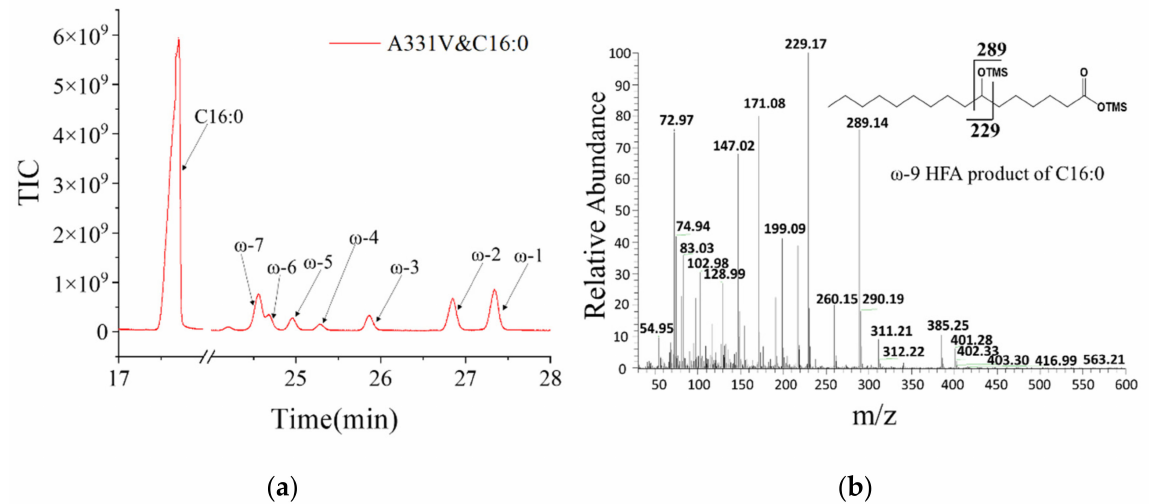
Figure 4. ( a ) Representative GC chromatogram showing substrate and product peaks from analysis of TMS derivatized reaction extract from conversion of C16:0 substrate by A331V mutant of BAMF2522. ( b ) Representative mass spectrum for the TMS derivative of ω -9 HFA (7-hydroxy palmitic acid) product of C16:0, indicating the fragmentation pattern used to identify the product. GC chromatograms and mass spectra of all other products are given in the Supplementary